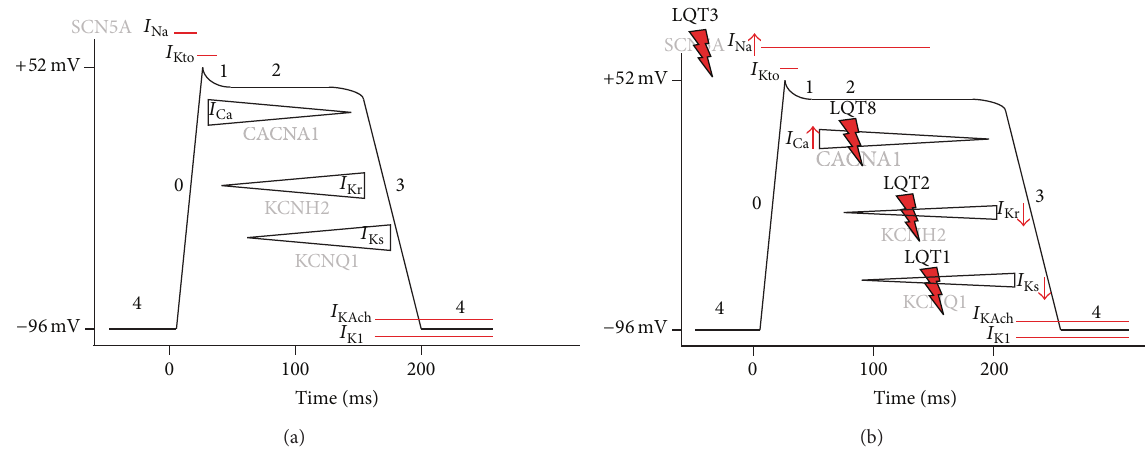
Figure 1: Schematic delineation of the cardiac action potential—resting “4,” upstroke “0,” early repolarization “1,” plateau “2,” and final and 𝐼 . Delayed rectifier currents: 𝐼 , 𝐼 . Inward rectifier currents: 𝐼 , 𝐼 . Adapted from repolarization “3.” Inward currents: 𝐼 Na Ca Kr Ks K 1 Kach [3]: (a) normal cardiac action potential. Different currents are allocated to their chronology in the AP course. Ion channel genes are written semitransparent. (b) Different LQTSs are shown in relation to their distinct ion current causative for the indicated syndrome. Overactivation/reduction of different currents leads to a significant elongation of the action